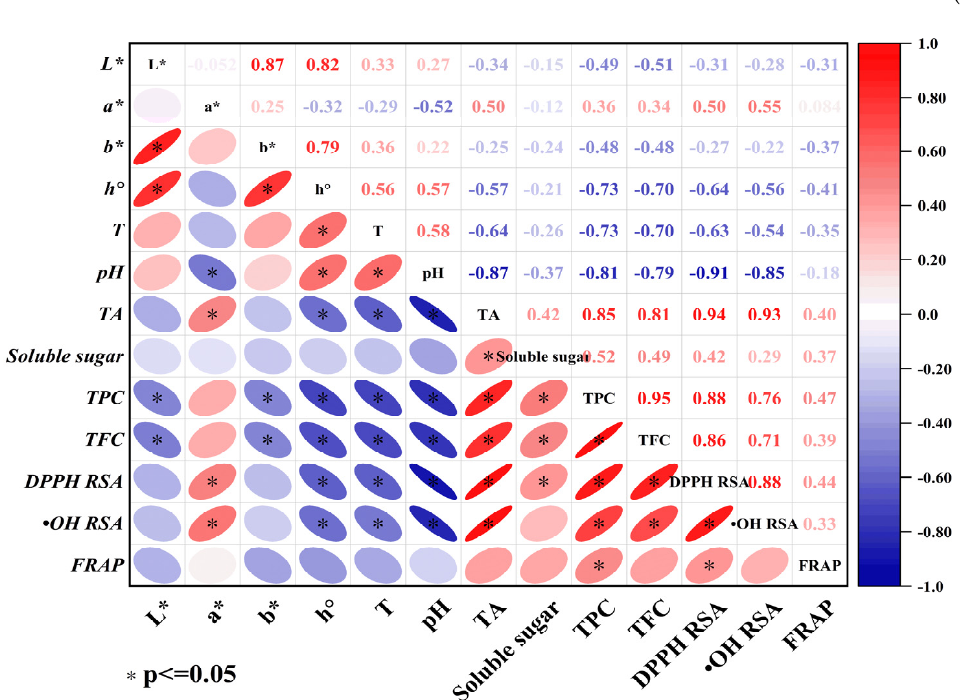
Figure 1. Spearman correlation coefficient heat map of physicochemical properties and antioxidant activities of pear pastes prepared from 23 cultivars. Red color means positive correlation, while blue means negative. Meanwhile, the darker the color and the flatter the ellipse indicates the stronger correlation, while the correlation is not significant when color is light and ellipse is close to a circle. The correlation significant level was set at p ≤ 0.05.